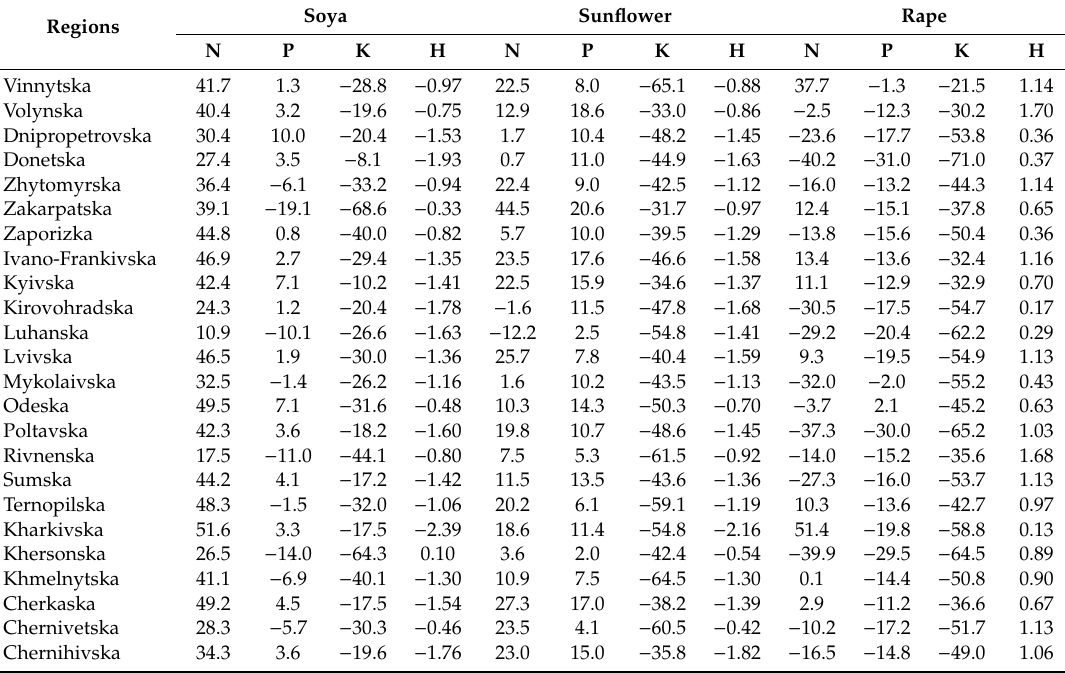
Table 5. Soil nutrient balance for the production of industrial crops in Ukraine by region (calculated for 2017).